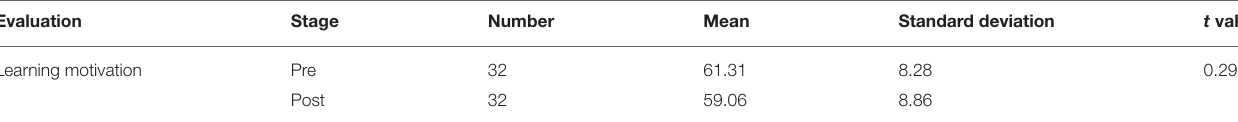
TABLE 2 | Pre- and post-test t -test of the learning motivation effect of traditional physical education.